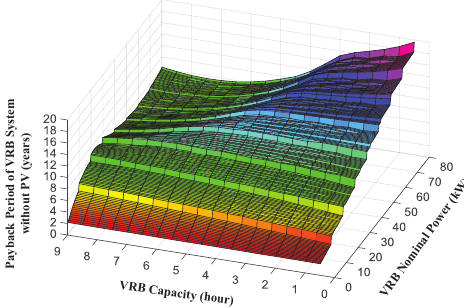
Figure 14. Payback period of the VRB system without PV (years).